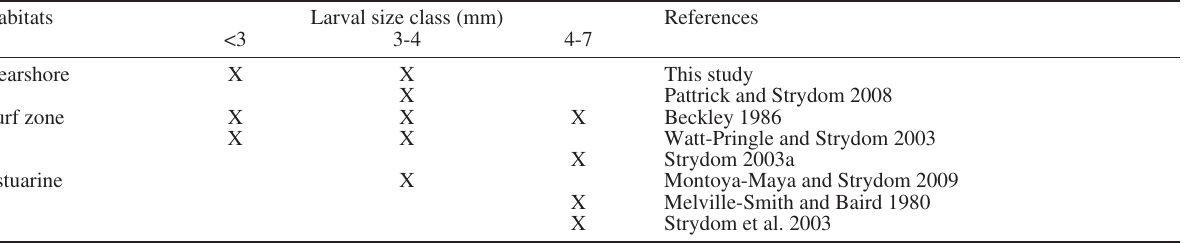
Table 4. – Review of the occurrence of various body lengths of S. turbynei larvae in temperate coastal habitats.